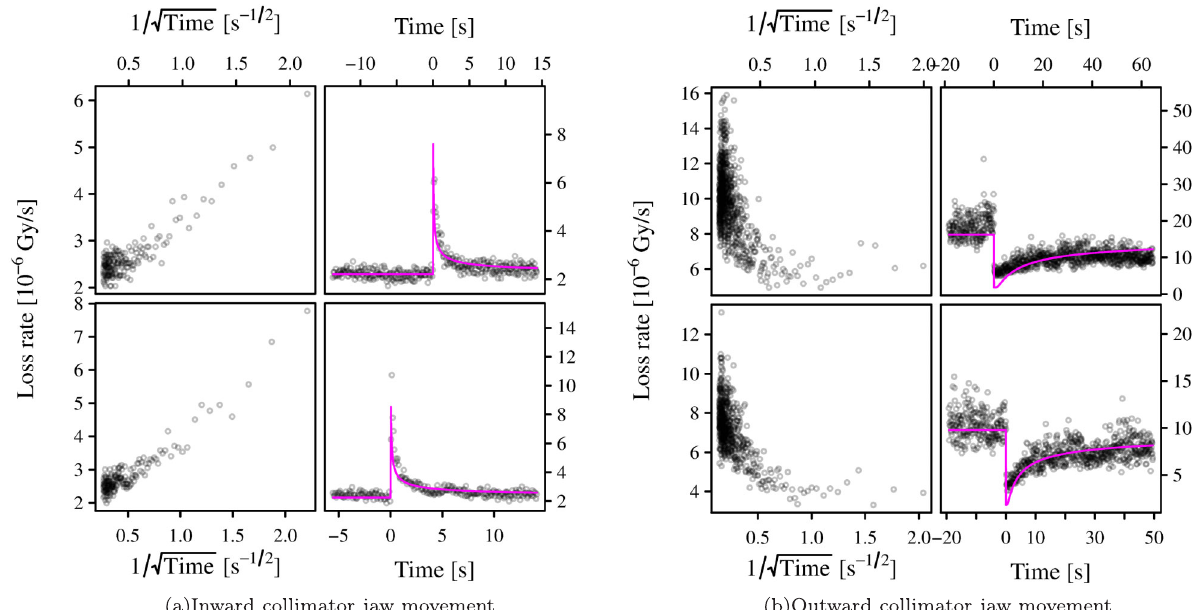
FIG. 11. Examples of loss-rate responses to inward (left panel) or outward (right panel) collimator steps. In each panel, the plots on the left side show the decay as a function of 1 = the right side of each